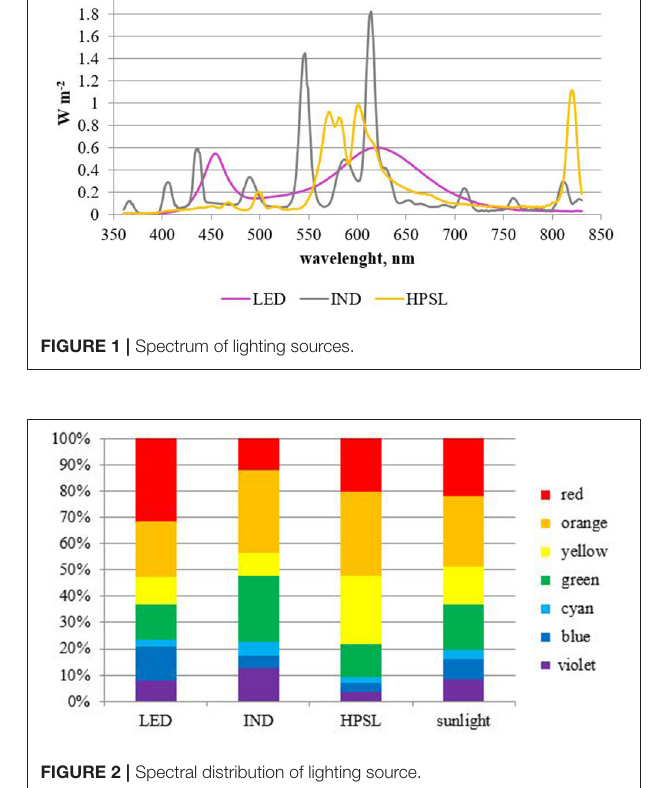
FIGURE 2 | Spectral distribution of lighting